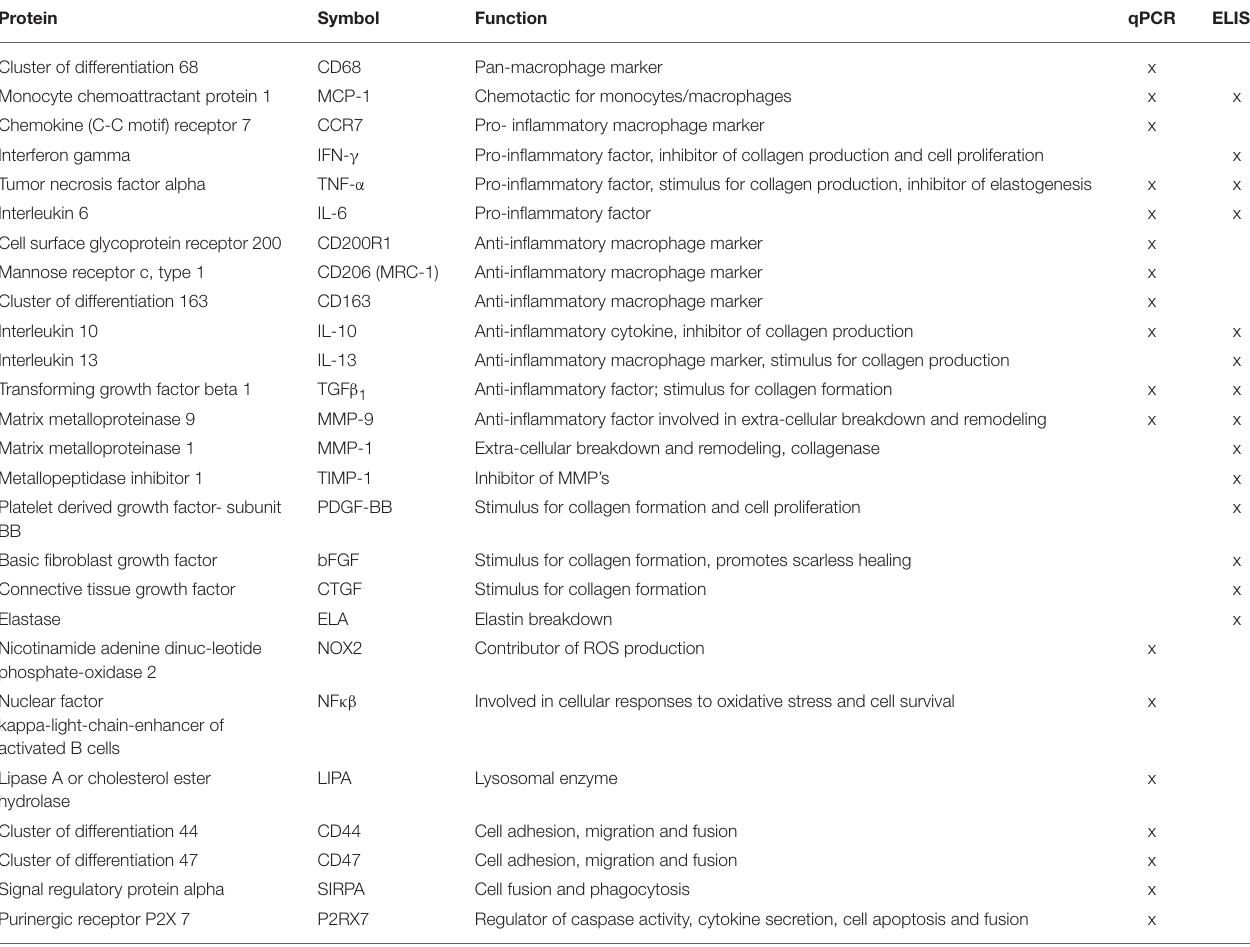
TABLE 3 | Genes and proteins analyzed via qPCR and Multiplex ELISA. Protein